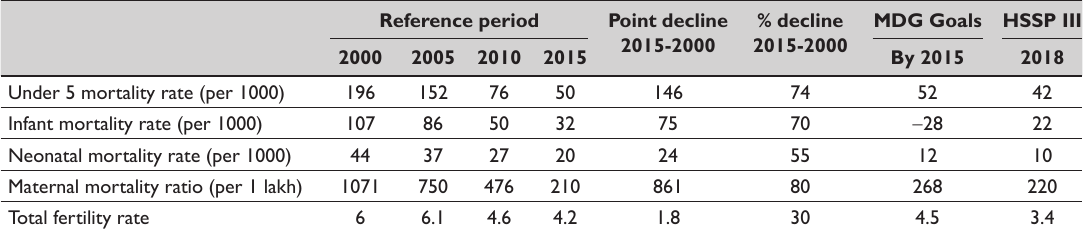
Table 1: Mortality profile of maternal and child health, decline and proposed targets in Rwanda